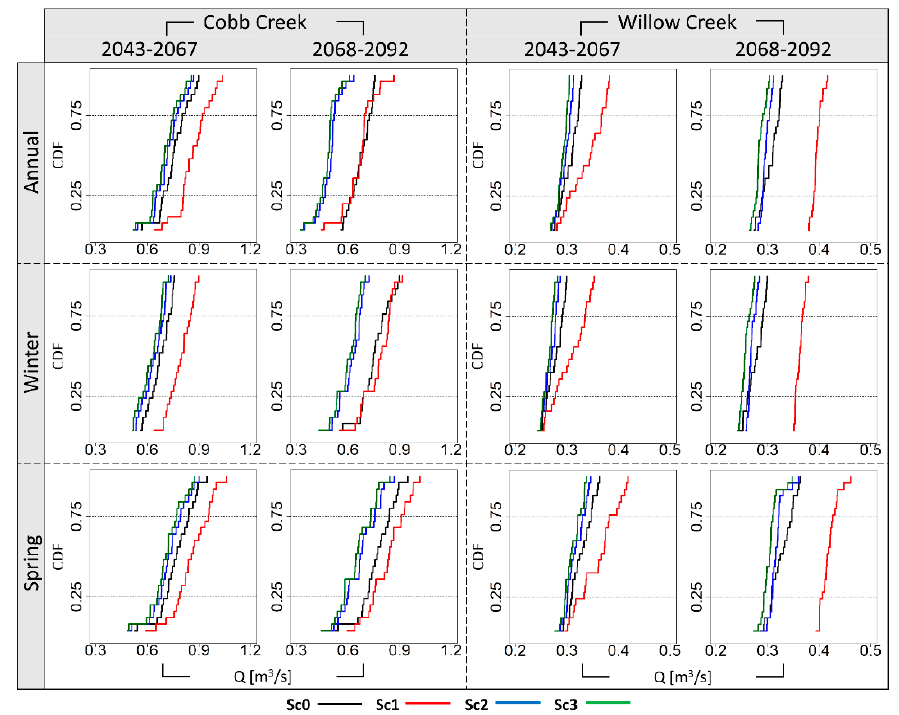
Figure 6. Cumulative density functions of mean seasonal streamflow at the Cobb and Willow Creek sub-watersheds for the 2043–2067 and 2068–2092 periods under the di ff erent sub-watersheds for the 2043–2067 and 2068–2092 periods under the different scenarios.